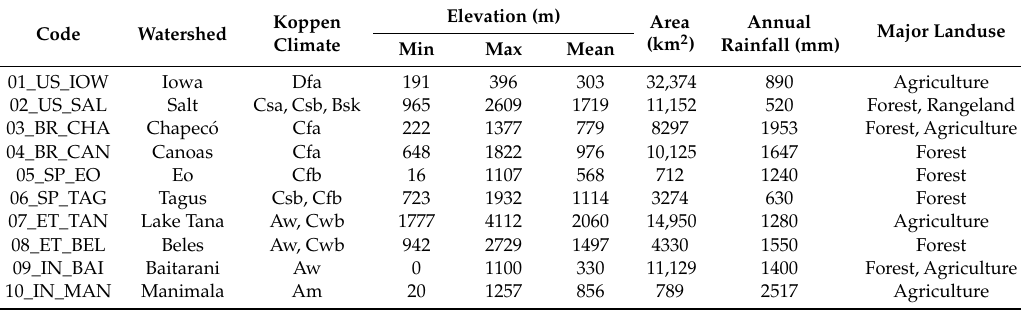
Table 1. List of watersheds used, and the codes used to specify them for this